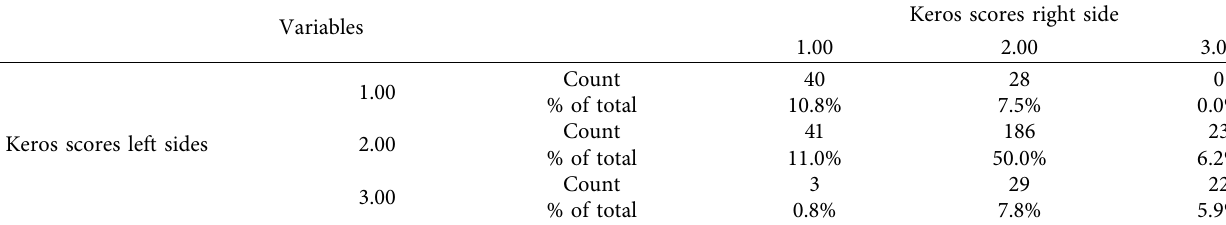
Table 3: Keros scores in the right and left sides.